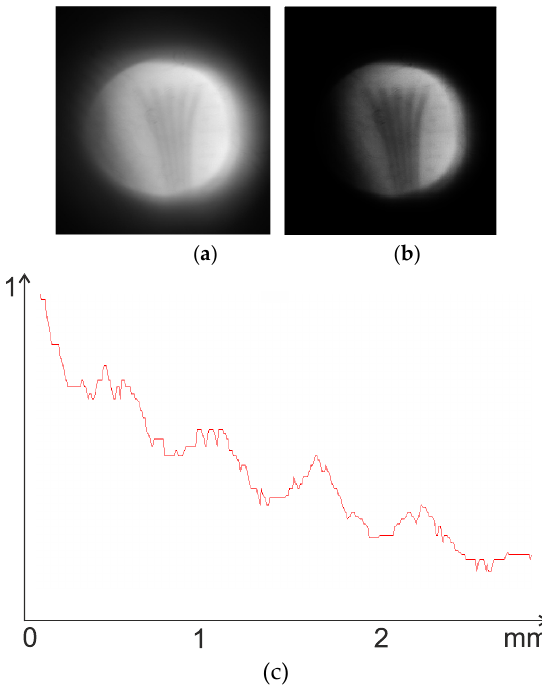
Figure 13. A black and white test pattern for testing lenses obtained in the system with an annular aperture. ( a ) original view; ( b ) After increasing the contrast; ( c ) Cross-section of (b)